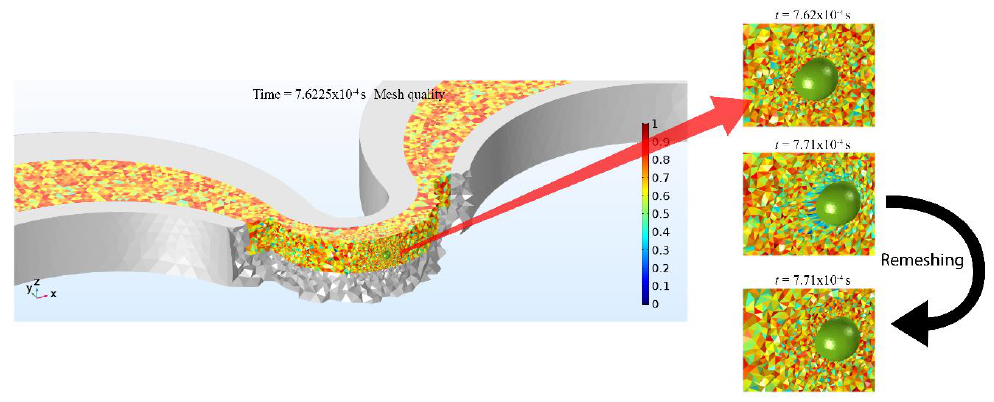
Figure 5. Different stages of the movement of a Ø = 10 µ m spherical domain (green sphere) through the fine (rainbow) mesh. The last picture shows the remeshing of the fine mesh. Bluish facets in the fine mesh represent low mesh quality regions.